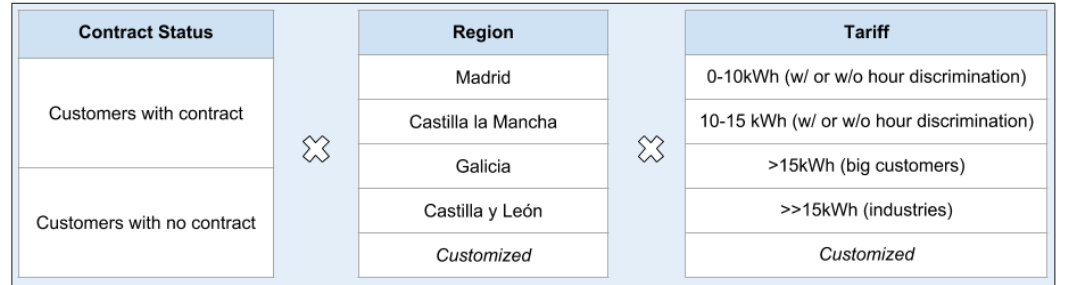
Figure 6. Our system can be fully configured. The contract status, the region and the tariff of the customer can be set before starting the process, allowing dozens of different configurations, generating successful tailored